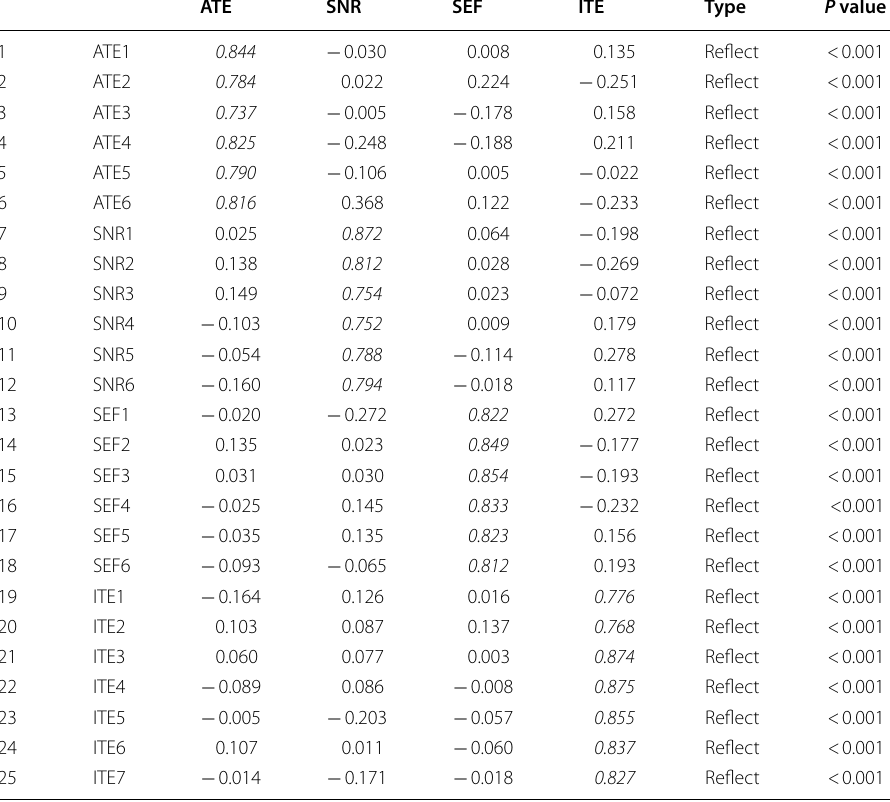
Table 3 Combined loadings and